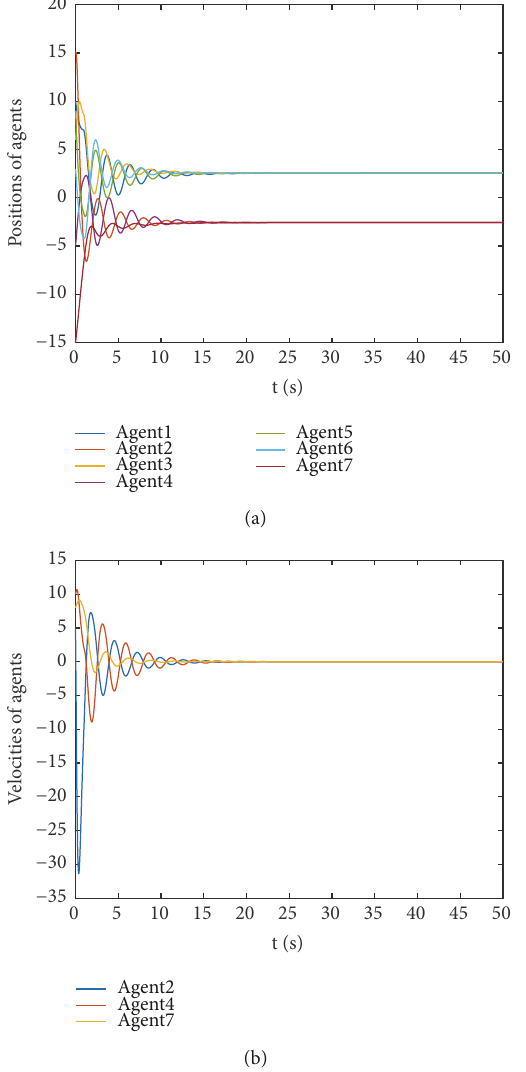
Figure 4: The state trajectories of the agents under undirected topology in Figure 1 with different input time delays 𝜏 1 = 0.2 , 𝜏 2 = 0.1 , 𝜏 = 0.1 , 𝜏 = 0.1 , 𝜏 = 0.15 , 𝜏 = 0.25 , 𝜏 = 0.2 , communication 3 4 5 6 7 delay 𝜏 𝑖𝑗 = 0.9 . (a) Positions. (b)